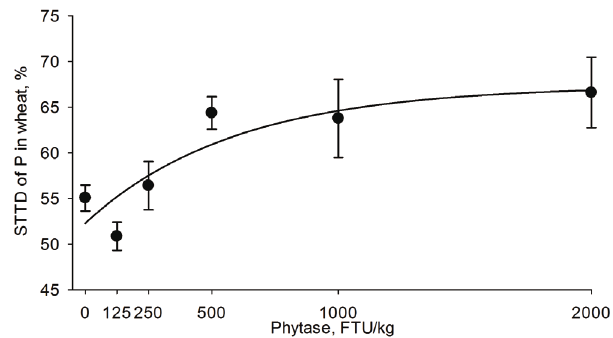
Figure 6. Fitted exponential model of standardized total tract digestibility (STTD) of P in wheat as a function of concentration of exogenous phytase in the diet. Treatment means ( ● ) and standard error are shown. STTD of P = 52.2951+15.0552×[1–exp(–0.0017 ×phytase dose in FTU/kg)], r 2 = 0.80, p<0.001. The concentration of phytase needed to maximize (i.e., to obtain 95% of the upper asymptote) the STTD of P at 64.0% was calculated to be 881 FTU/kg. FTU, phytase units.